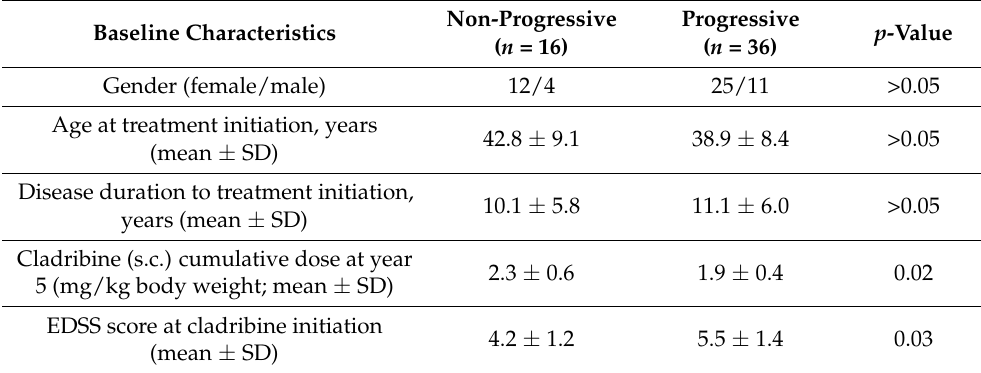
Table 4. Baseline characteristics of progressive and non-progressive patients at year 5, based on analysis of change in EDSS score from year 1 (induction treatment termination).